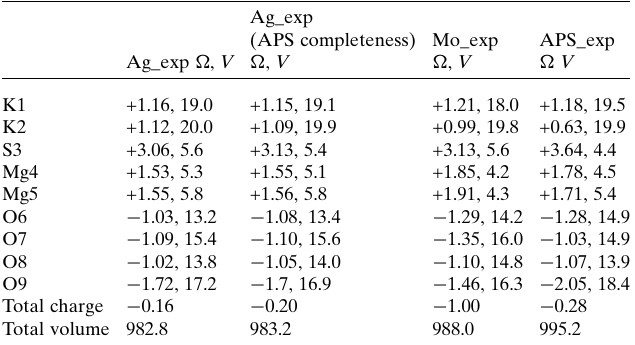
Table 2 Net atomic charge (cid:3) (e (cid:4) ) at atoms/ions and atomic/ionic volumes V (A˚ 3